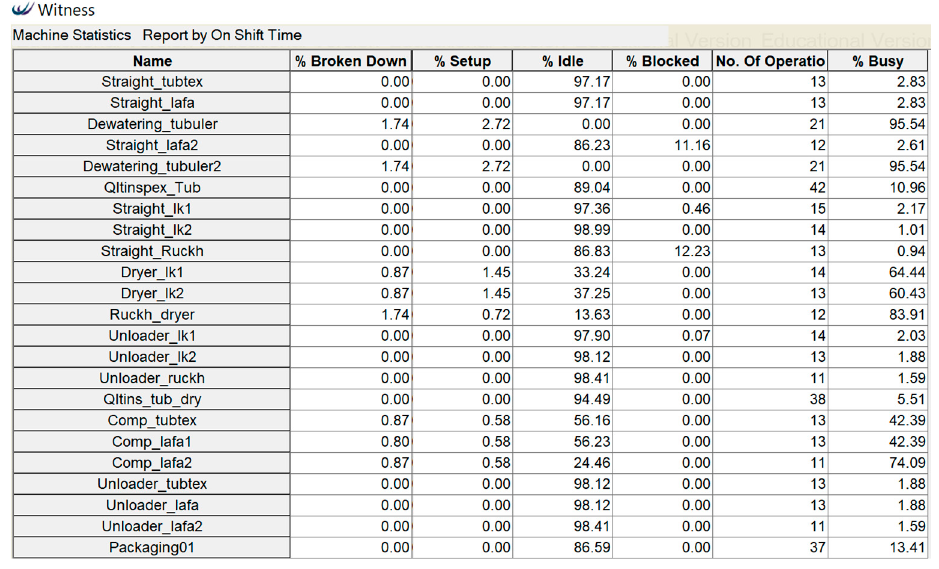
Figure 7. Machine statistics for the finishing section.